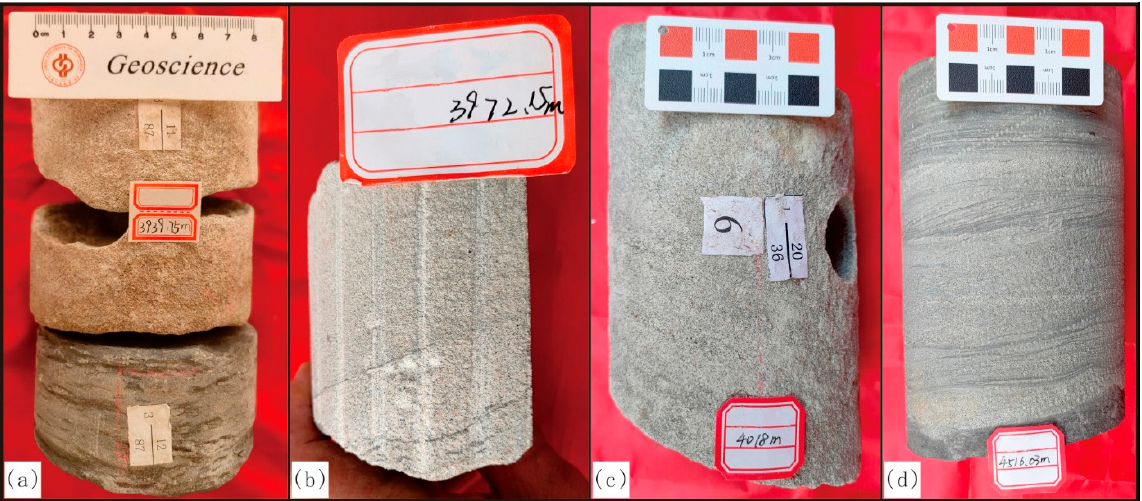
Figure 7. Typical sedimentary structure of subaqueous distributary channel microfacies in shallow- water delta outer front. ( a ) Well QS1, 3939.75 m, scour surface structure; ( b ) Well QS2, 3972.15 m, parallel bedding; ( c ) Well QS201, 4018.00 m, parallel bedding; ( d ) Well QS201, 4016.03 m, wedge cross bedding.